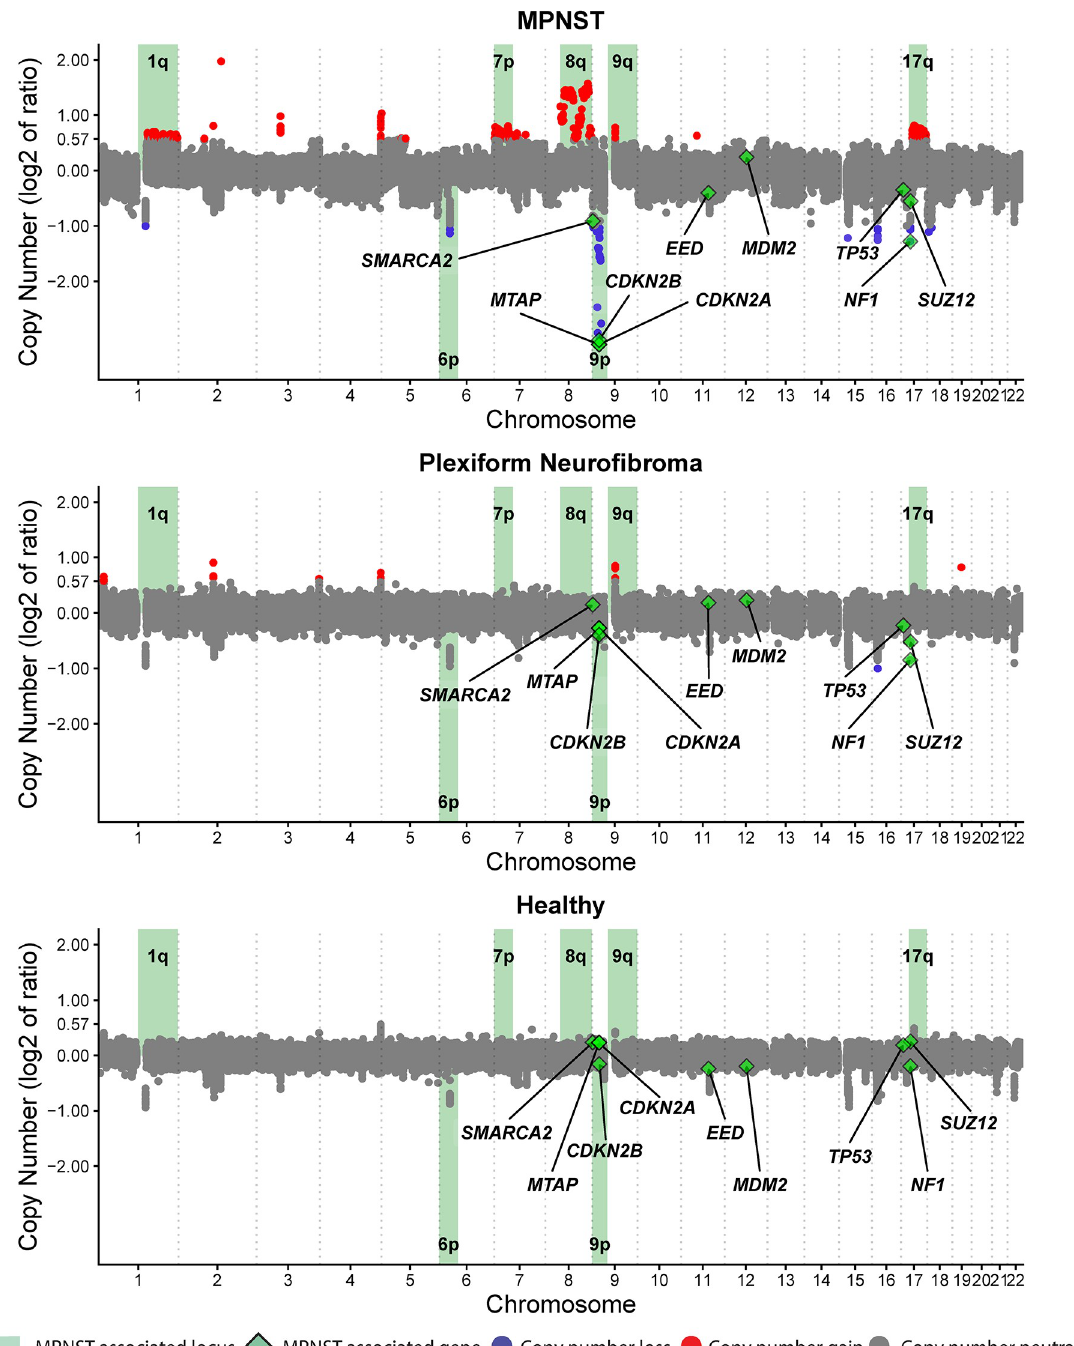
Fig 3. Aggregate CNAs measured across the genome. Plots represent plasma cfDNA data compiled from all blood plasma specimens from (A) MPNST ( n = 46), (B) PN ( n = 23), or (C) healthy donors ( n = 16) in this study. Copy number ratios across the genome are shown on a log 2 scale with significant gains in red, significant losses in blue, and regions without significant gain or loss depicted in gray ( Methods ). Loci highlighted in green have been previously associated with MPNST or NF1, with associated genes also labeled and depicted by green diamonds. cfDNA, cell-free DNA; CNA, copy number alteration; MPNST, malignant peripheral nerve sheath tumor; PN, plexiform neurofibroma.